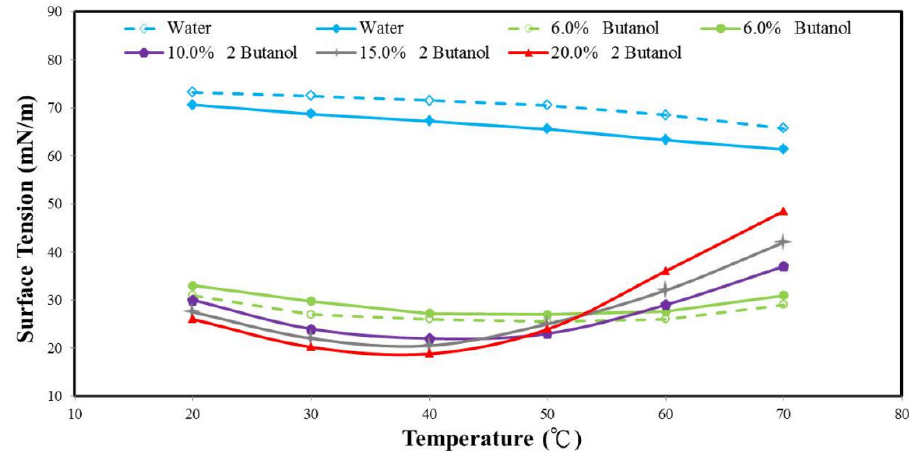
Figure 6. Surface tensions of different concentrations of aqueous solution as functions of temperature [11].